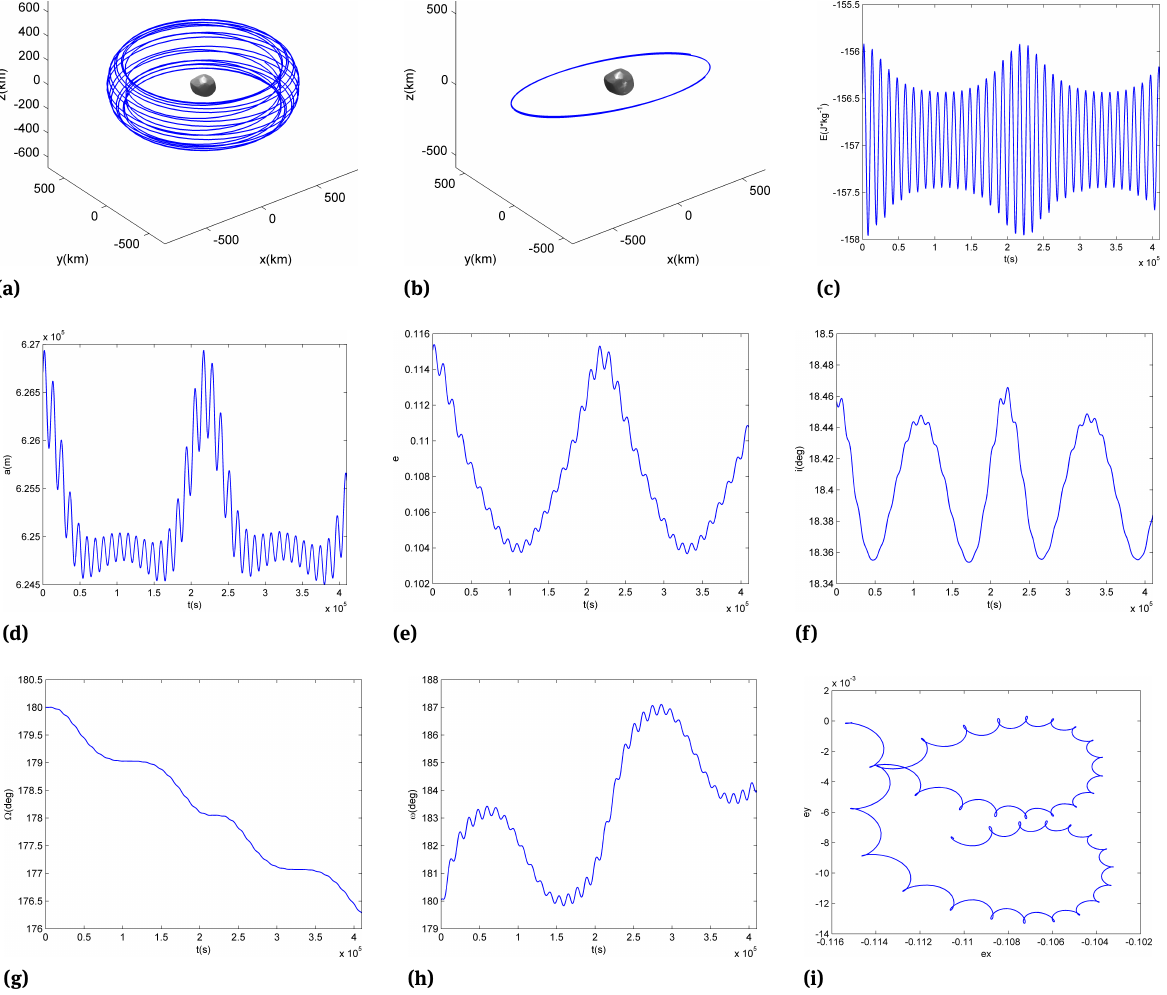
Figure 5. The first orbit in the gravitational potential of 45 Eugenia. (a) 3D plot of the orbit relative to the body-fixed coordinate system of principal axis of inertia; (b) 3D plot of the orbit relative to the inertia coordinate system; (c) Mechanical energy for the orbit; (d) Semi-major axis; (e) Eccentricity; (f) Inclination in the inertia coordinate system (xy plane of the inertia coordinate system is the same as the xy plane of the body-fixed coordinate system of principal axis of inertia, similarly hereinafter); (g) Longitude of the ascending node in the inertia coordinate system; (h) Argument of periapsis in the inertia coordinate system; (i) Eccentricity vector, e x = e cos( ω ) , e y = e sin( ω ).